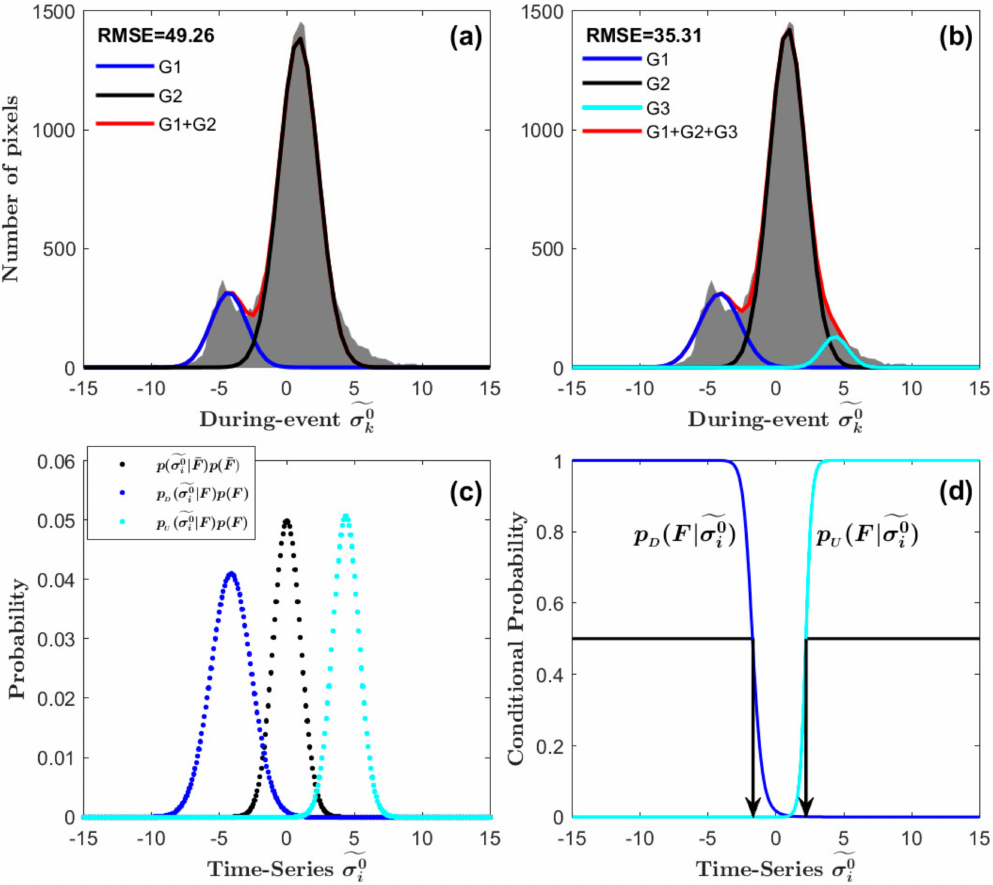
Figure 5. ( a ) The histogram and 2-Gaussian curve fitting for the during-event epoch in the normalized time series. ( b ) The curve fitting for 3-Gaussian model. RMSE = root-mean-square error. ( c ) The probability for the nonflooded, the flooded with intensity decrease, and the flooded cases, with intensity increase for the normalized backscattering in the time series. ( d ) The conditional probability of the normalized backscattering in the time series being flooded with intensity decrease (blue curve) or intensity increase (cyan curve). Black line with arrow indicates the cuto ff threshold of p = 0.5 for a binary flood